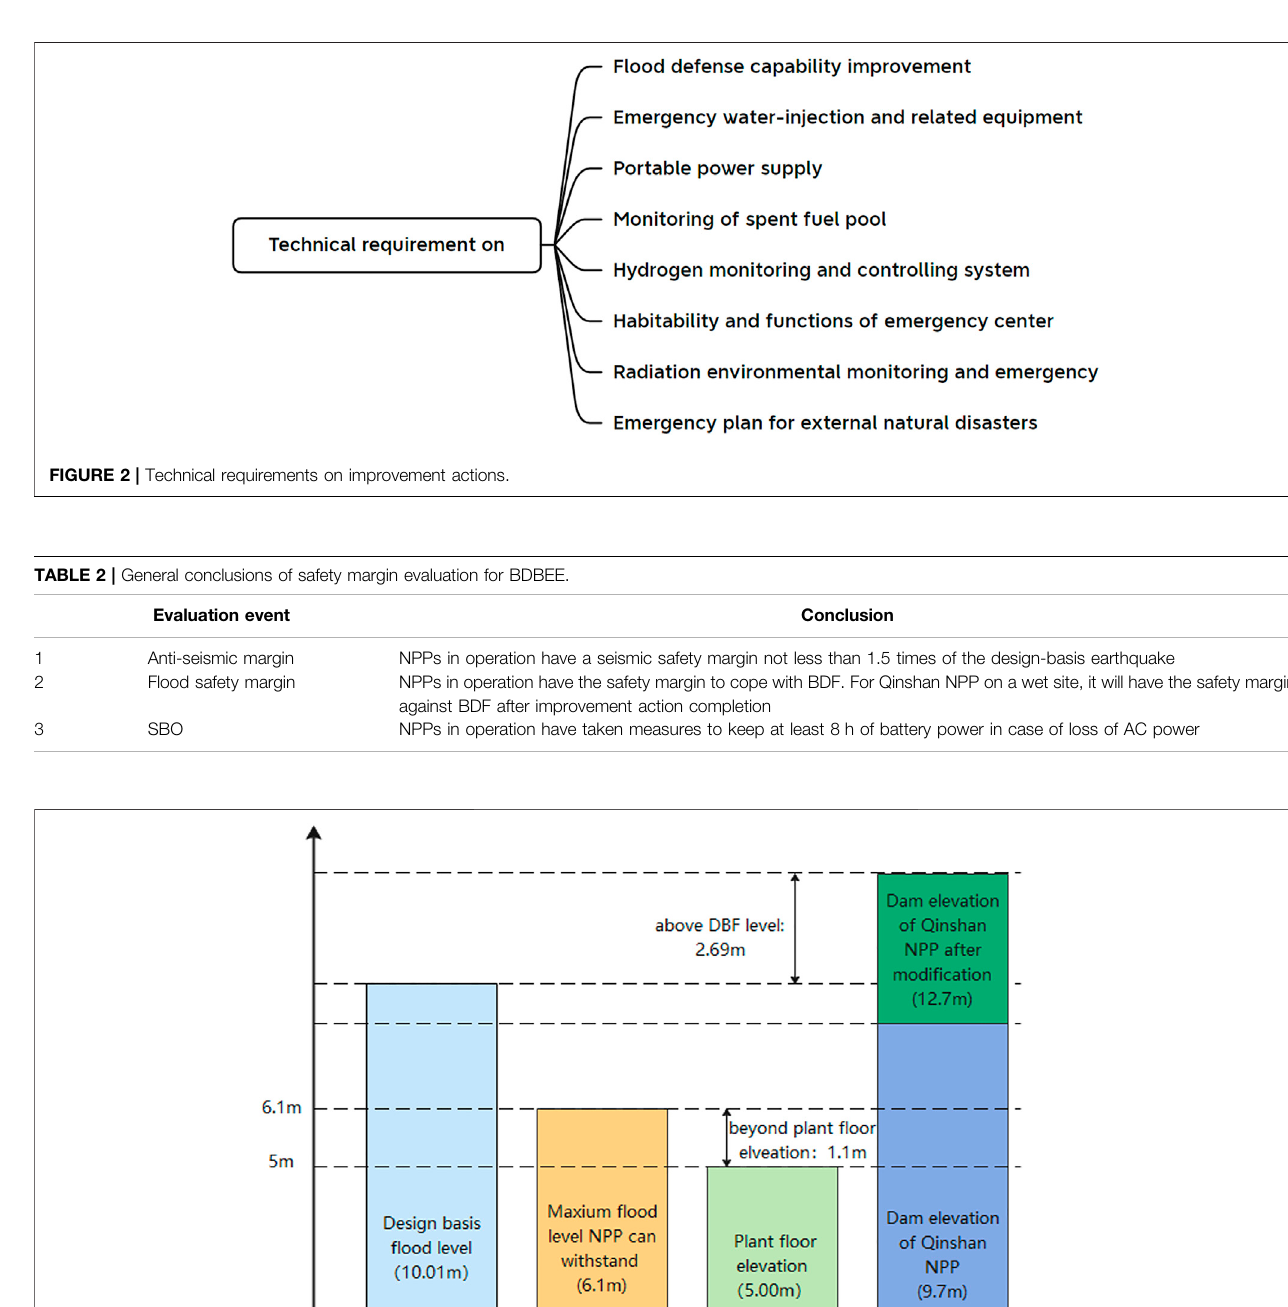
Table 2 . In Qinshan NPP, plant fl oor elevation is 5.00 m, the